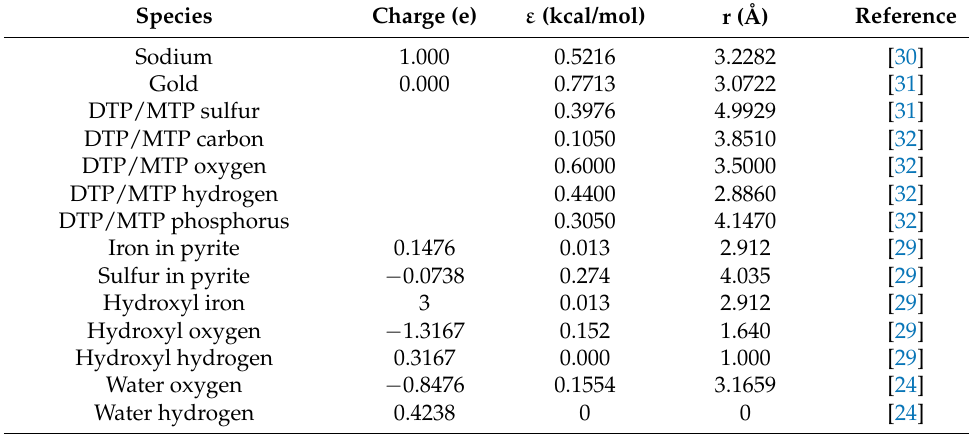
Table 2. The intermolecular potential